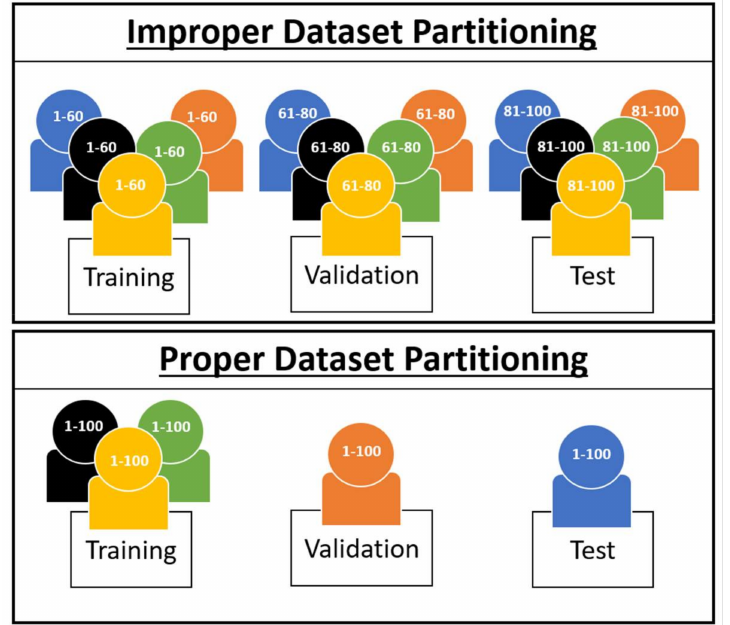
Figure 3. Two examples of creating the training, validation, and testing datasets with data from five participants. Numbers correspond to unique observations within each participant’s dataset, with “1–60” referring to observations #1 through #60, “61–80” referring to observations #61 through #80, etc. The top illustrates improper dataset partitioning: data from each participant are used for all three datasets. In the top panel, while no unique observation is in more than one subset, each participants’ data is still present in each subset. The bottom illustrates proper dataset partitioning: each participant’s data are present in no more than one of the